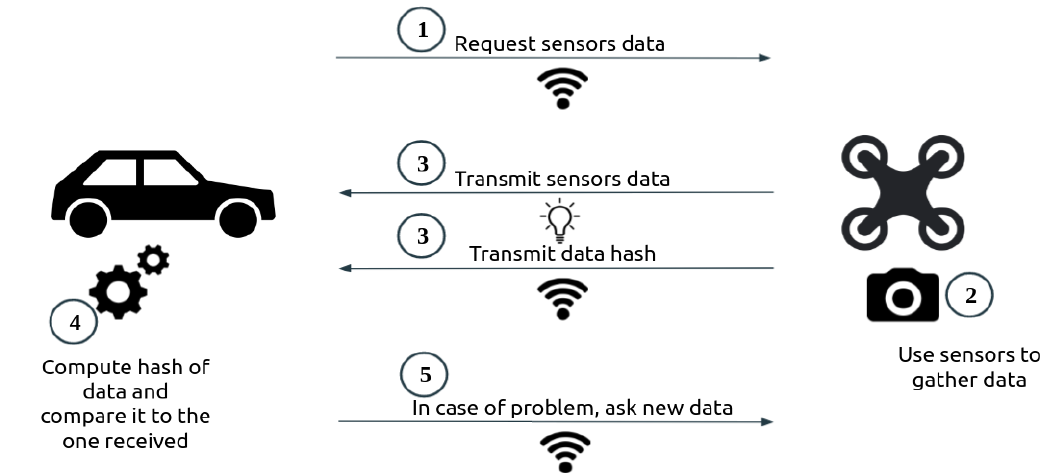
Figure 3. Illustration of the proposed communication